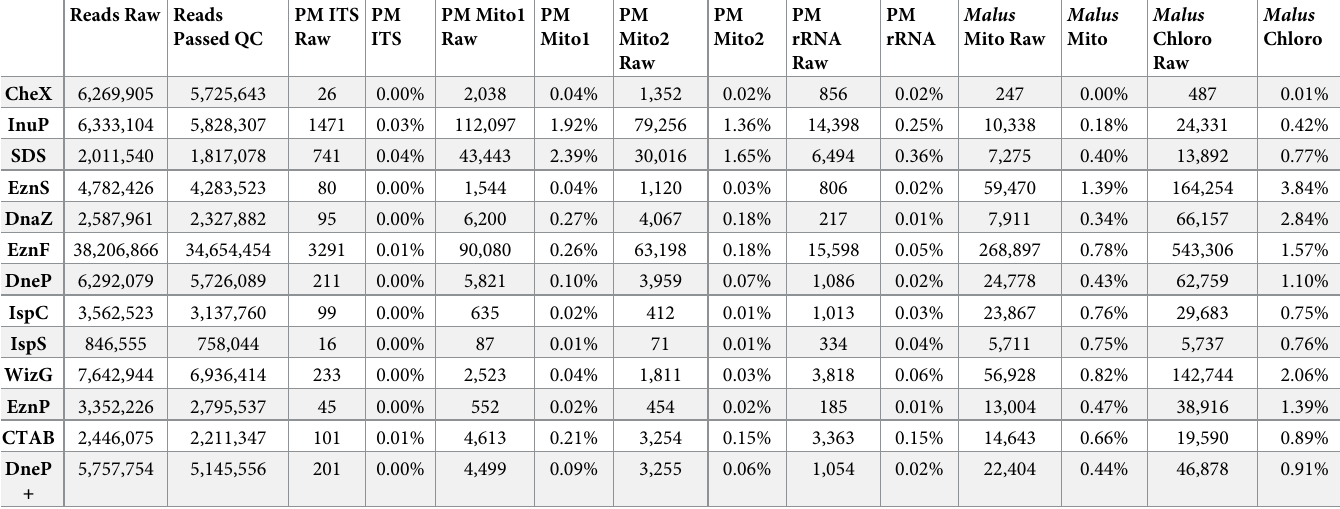
Table 6. NuGen Ovation 1 Ultralow system V2 VPRI P . leucotricha sequencing alignment results taken from vision